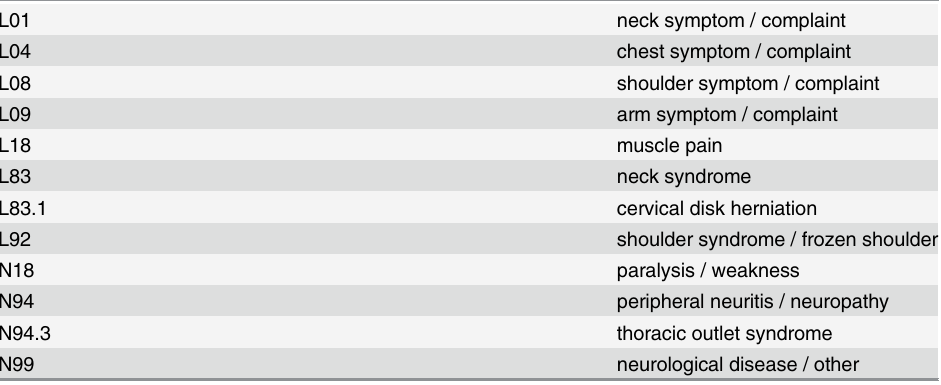
Table 1. ICPC codes used for patient identification in this